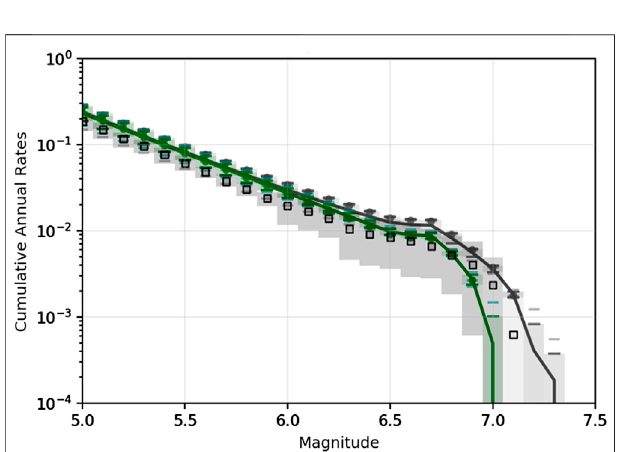
FIGURE 5 | SHERIFS ’ s synthetic earthquake rates resulting from the model considering 10 or 15 km for the seismogenic depth (black and green lines respectively) compared to the regional earthquake catalog rates (empty squares and gray pacthes) shown in Figure 2